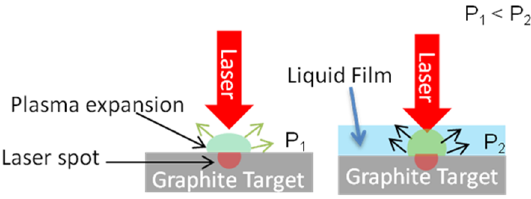
Figure 1. Schematics of laser ablation on dry graphite ( left ) and with a thin liquid film covering the graphite surface ( right ). Laser pulses strike the surfaces of the targets, producing plasma plumes (green), which expand into the gas (argon) atmosphere or the respective liquid, generating different local pressures (P 1 in gas and P 2 in liquid). In the liquid medium, the plasma is confined and causes a higher pressure than in gas: P1 < P2.